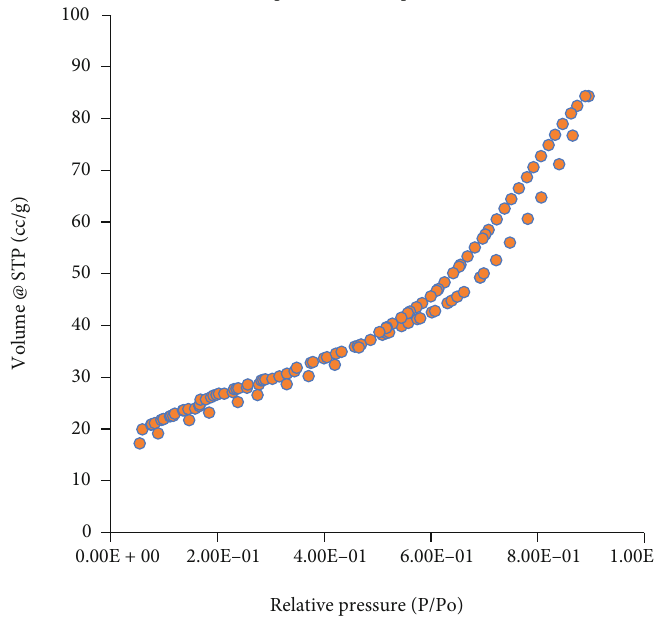
Figure 4: BET isotherm of Fe-zeolite A.